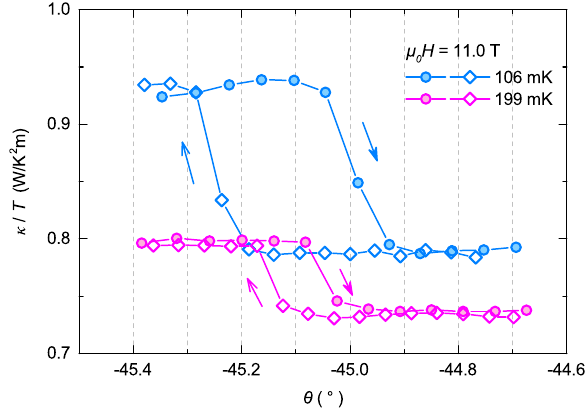
Sarrao,FIG. 6. The hysteresis of the hypersensitive switching via thermal conductivity around θ ¼ − 45 ° at 11 T and two temper- atures, 106 and 199 mK. The data for 106 mK are the same as in Fig. 1(e) of the main text. The widths of the hysteresis at two different temperatures are plotted in the inset of Fig. 2(a).